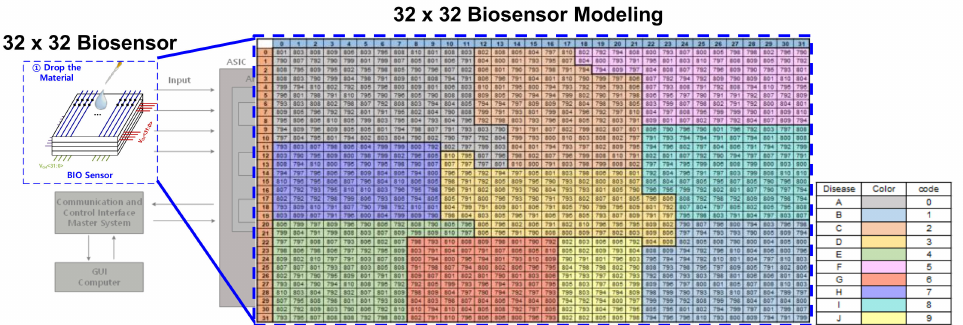
Figure 2. Input Feature Map of CNN. ADC output data extracted through the front-end block by receiving input from the biosensor.